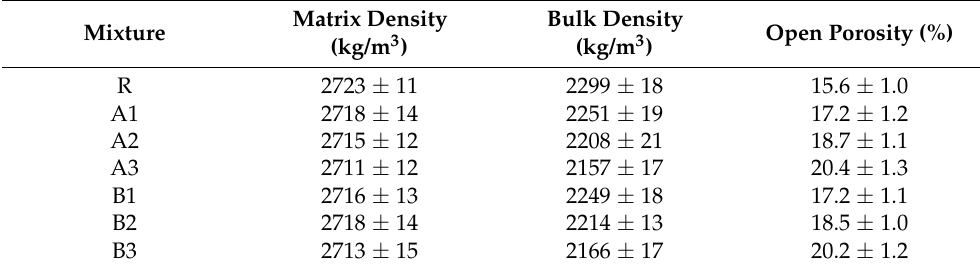
Table 4. Basic material properties of the designed cement mortars at 180 days.